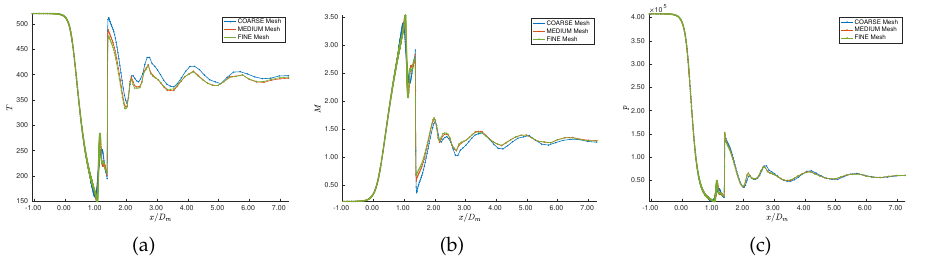
Figure 4. Temperature ( a ), Mach number ( b ) and pressure ( c ) distributions along the nozzle axis of symmetry at different grid levels (coarse mesh = 73 k cells; medium mesh = 170 k cells; fine mesh = 325 k